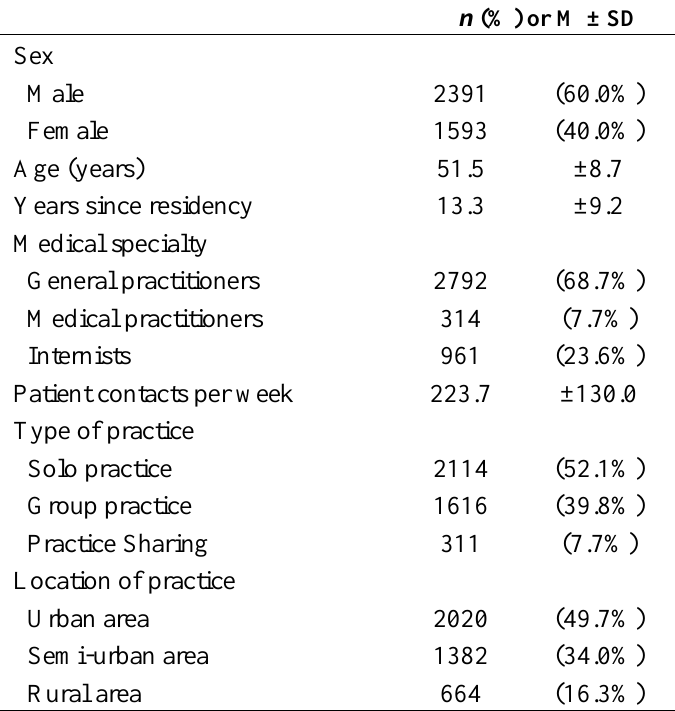
Table 1. Characteristics of PCPs ( n = 4074) included in the ÄSP-kardio Study, Germany.